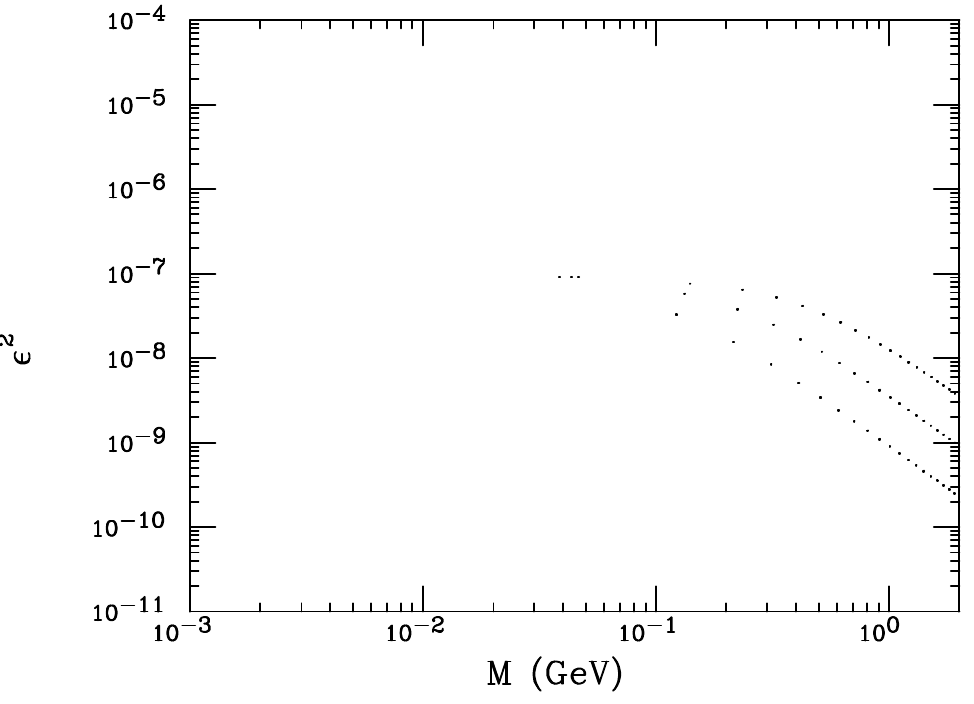
Figure 14 . Sample loci of points for Model 1 assuming R (cid:0) 1 = 100 MeV and (cid:15) 1 = 3 (cid:1) 10 (cid:0) 4 for, from top to bottom, (cid:14) A = 0 : 1 ; 1 ; 2,